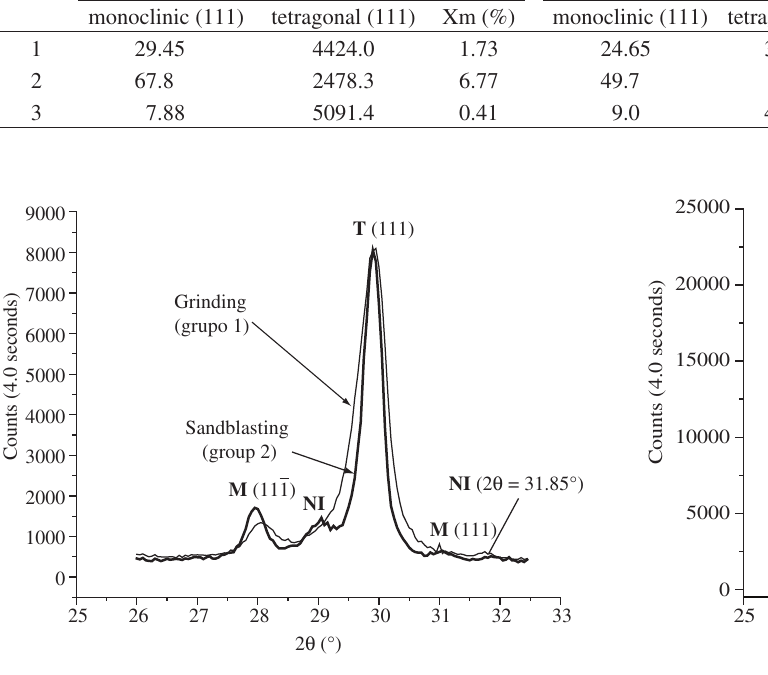
Figure 6. X ray diffractions of a non-infiltrated ZTA and a ZTA covered by a thick layer of infiltrated glass. Note the superposition of the non-identified glass peak with the monoclinic